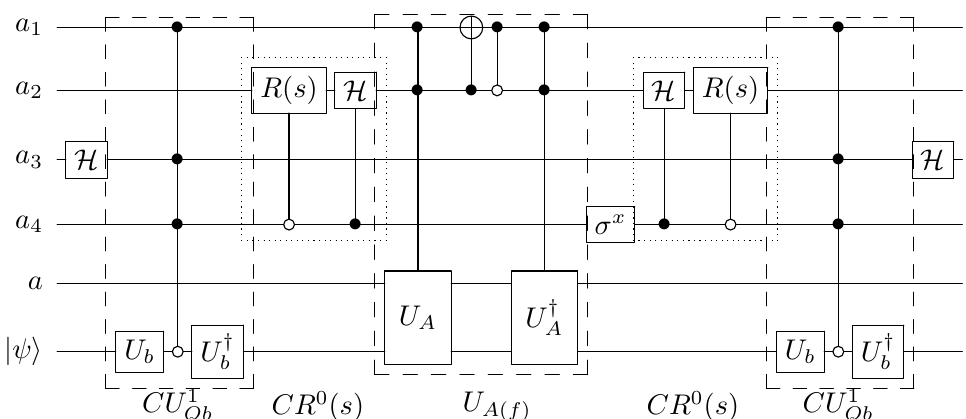
and U A ( f ) , whereas the dotted boxes Qb and CR 1 ( s ) are implemented via CU 1 and Qb Qb